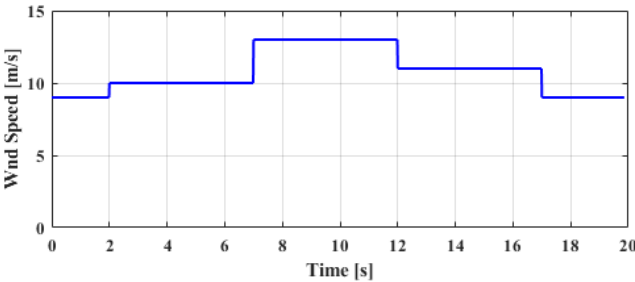
Figure 7. Wind speed